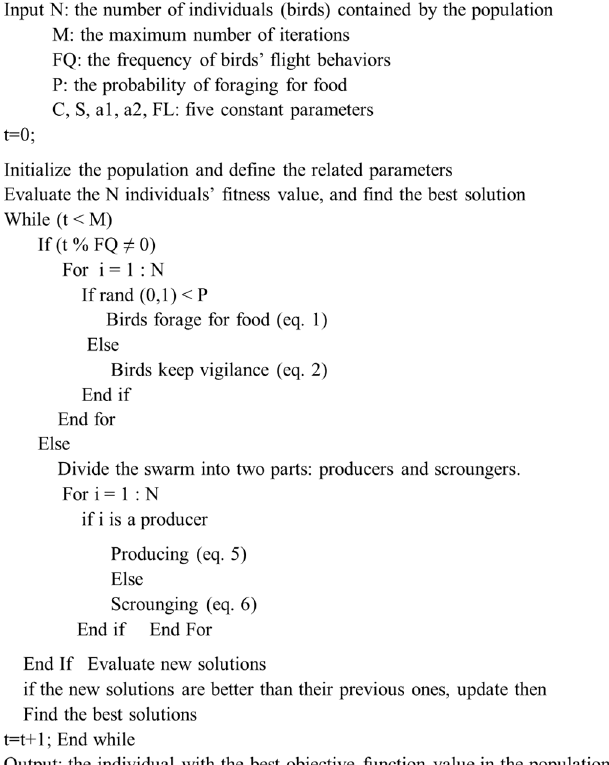
Figure 1. Bird swarm algorithm pseudocode.